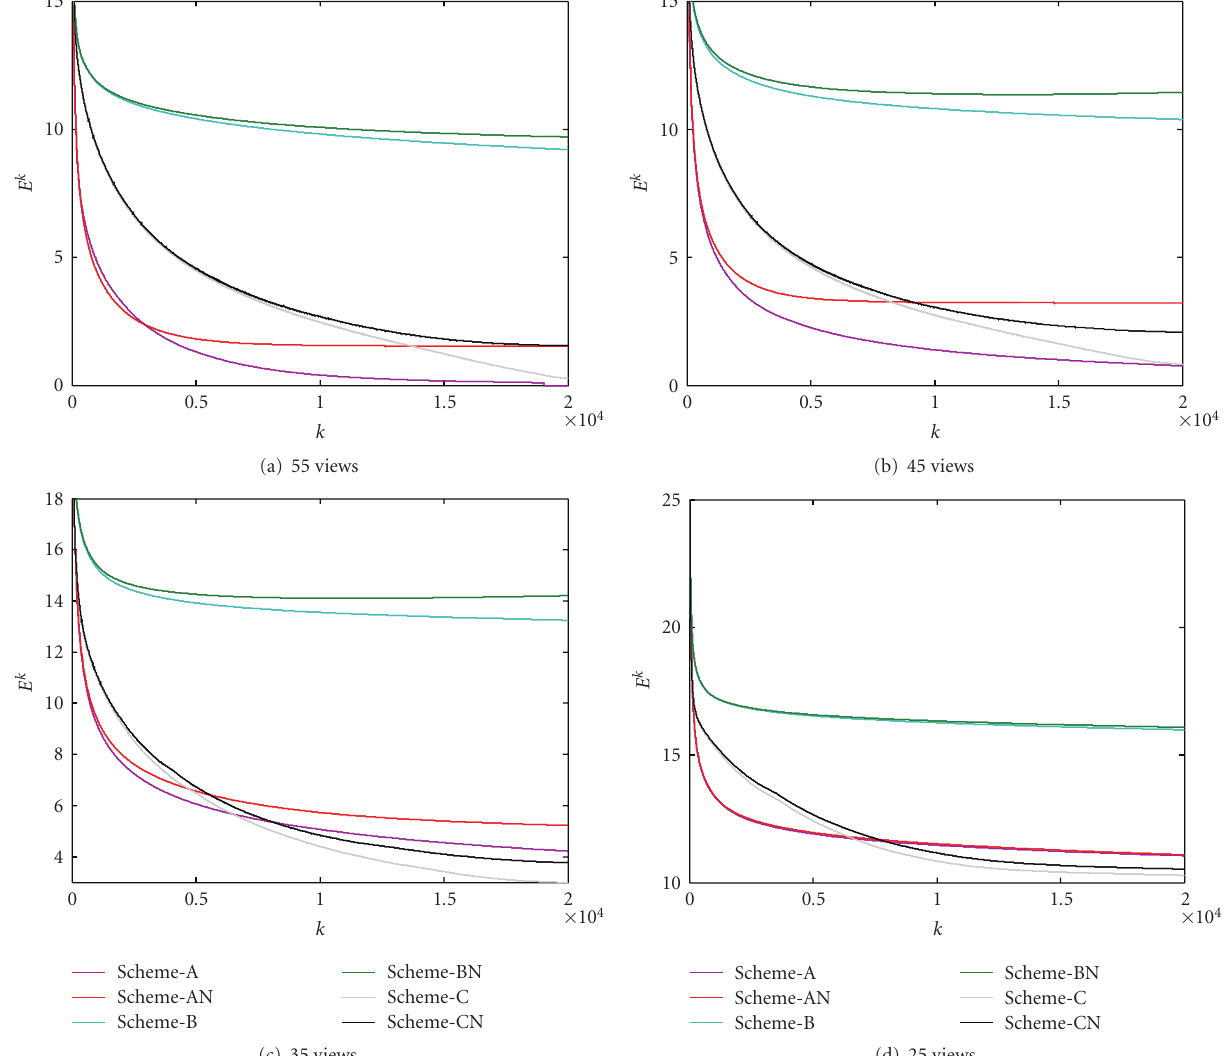
Figure 4: Relative error curves for various reconstructions from noisy projection. The numbers of projections were set to (a) 55, (b) 45, (c) 35, and (d) 25, respectively, where the horizontal and vertical axes represent the iteration index k and the corresponding log error E k ,